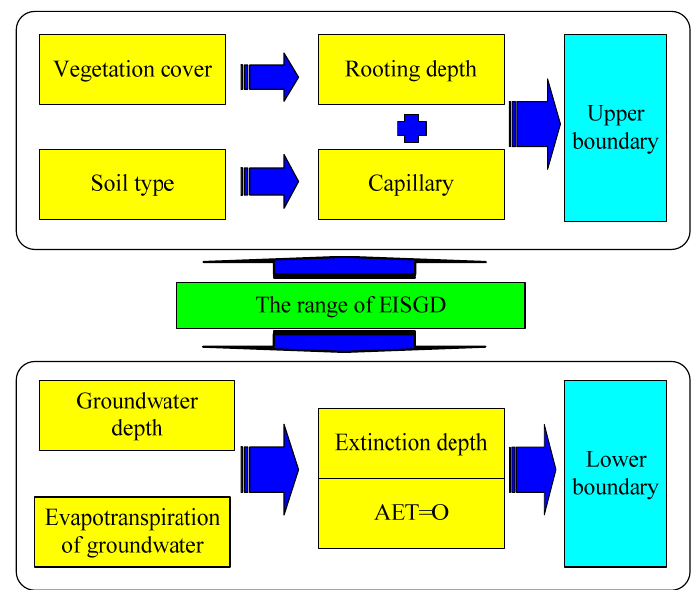
Figure 2. Flow chart of the conceptual model for determining ecologically ideal shallow groundwater depth (EISGD).